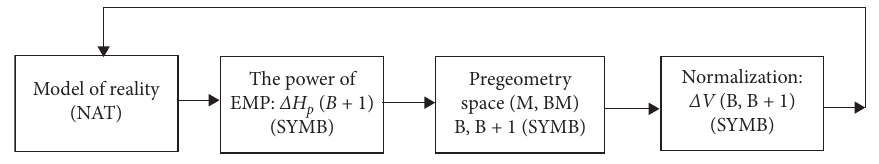
Figure 2: The analysis of